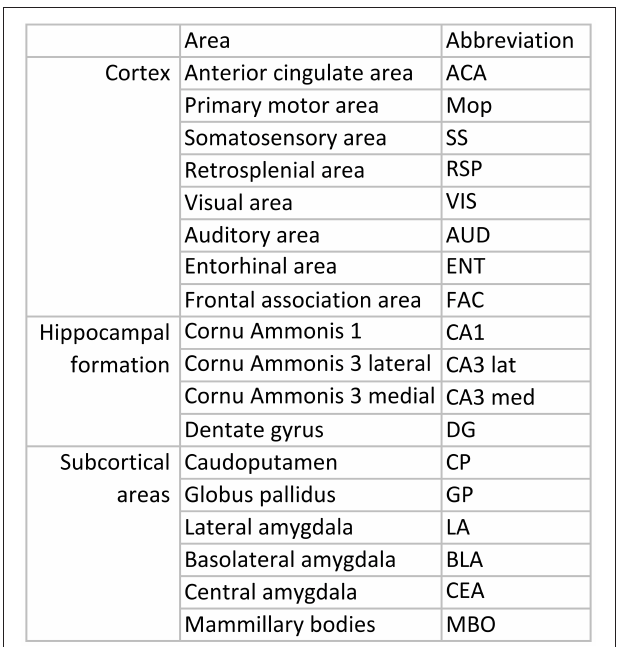
FIGURE 3 | List over regions and